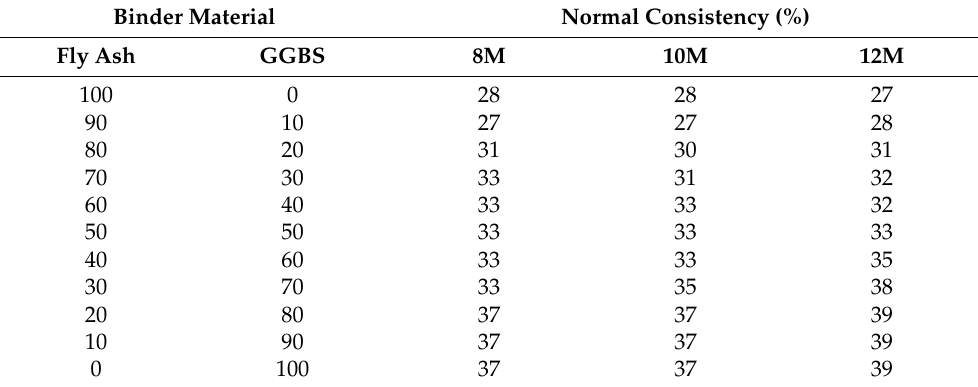
Table 7. Results of normal